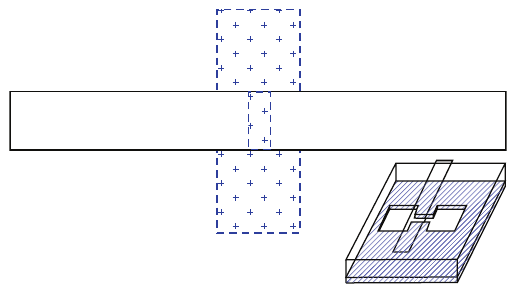
Figure 1: Microstrip line having DGS on the ground plane.